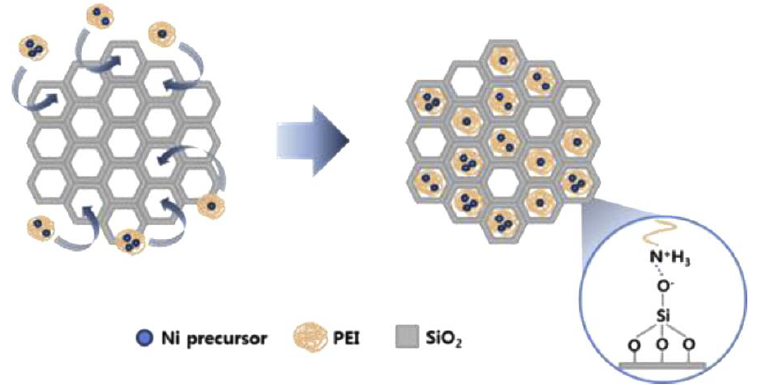
Figure 8. Schematic diagram of PEI-aided route. Reproduced with permission from reference [155].